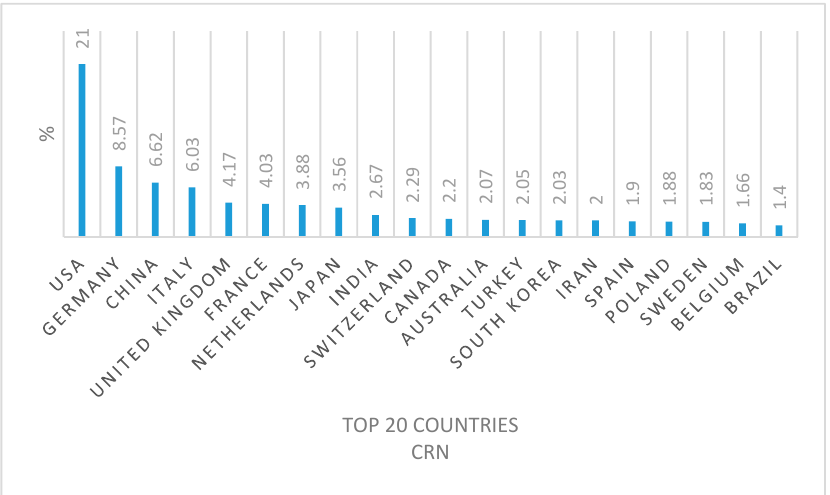
Figure 7. The top 20 countries most contributing to conventional radionuclide publications (2008– 2018).